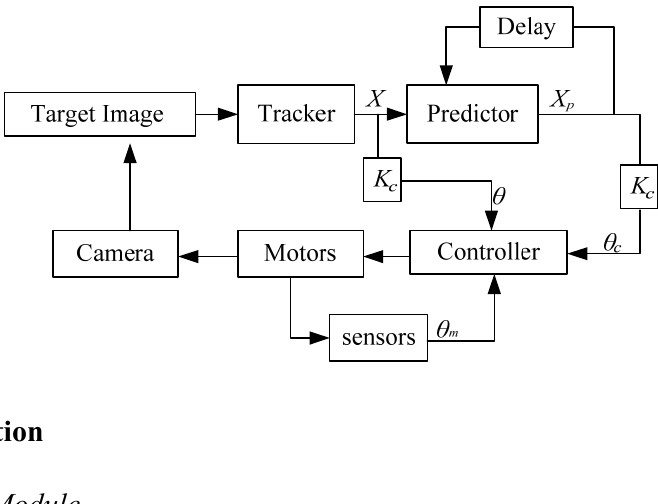
Figure 2. Signal flow diagram of a typical target tracking system.